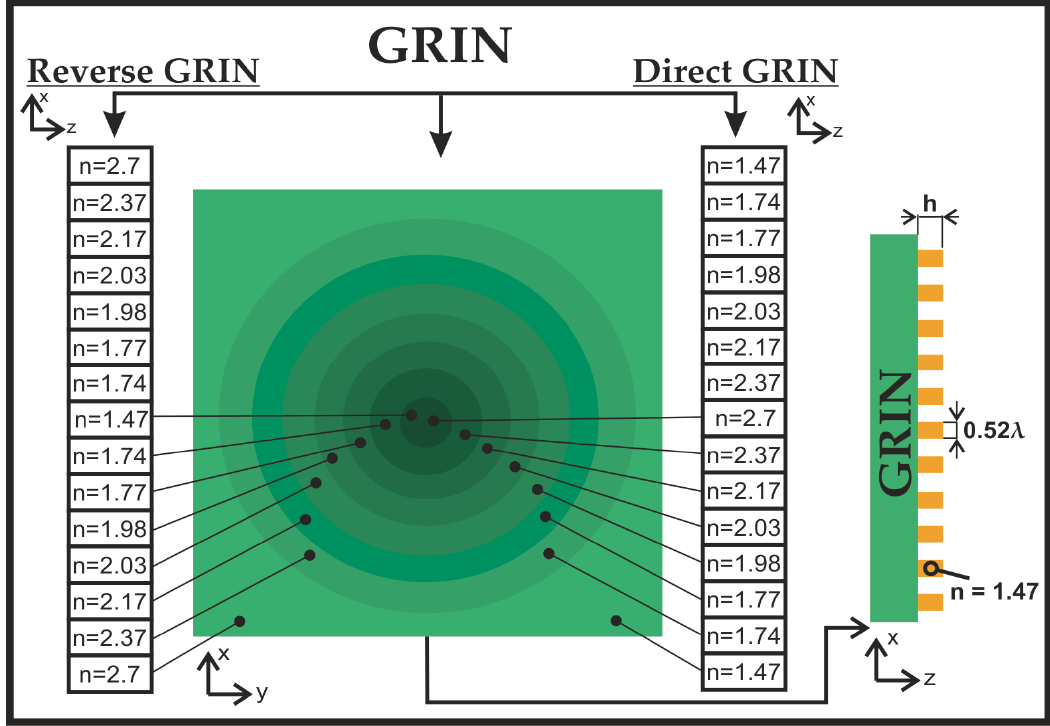
Figure 1. Appearance of direct and reverse GRIN substrates and cross sections xy and xz .